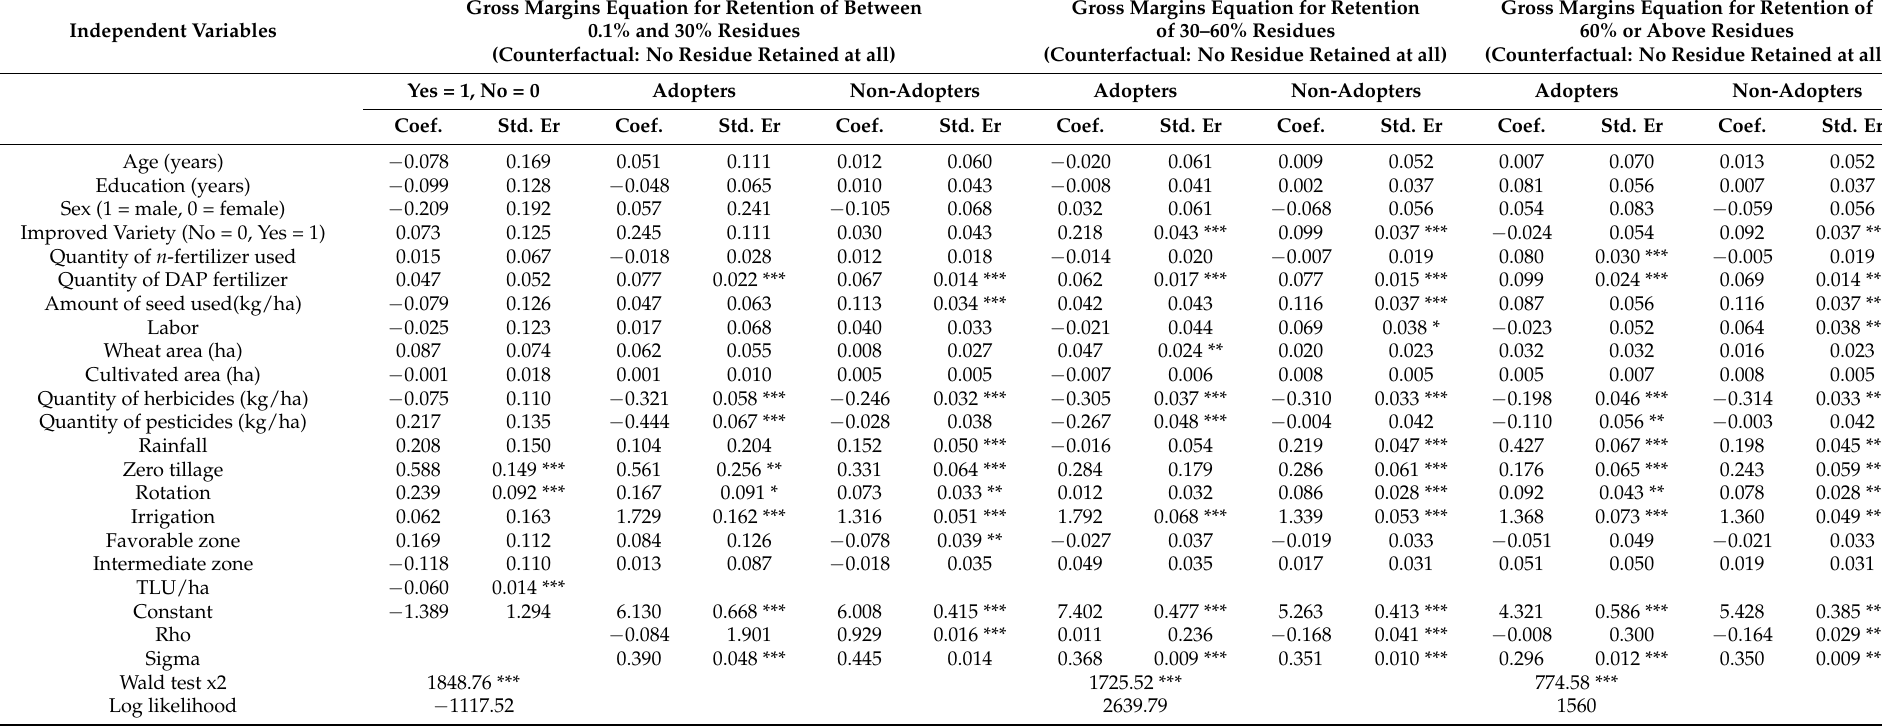
Table 5. Full information on maximum likelihood estimates of the endogenous switching regression models for measuring impacts of retaining different levels of residue on gross margins